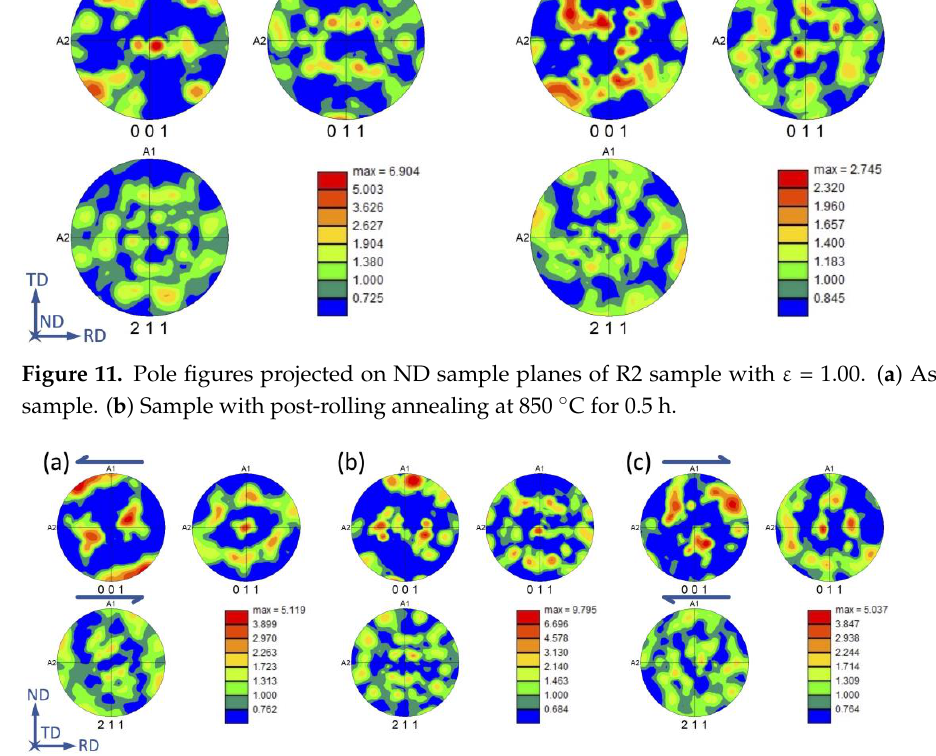
Figure 12. TD pole figures in the as-rolled R2 sample with ε = 1.00 for regions: ( a ) Top, ( b ) Central, and ( c ) Bottom. The arrow indicates redundant shearing strain.